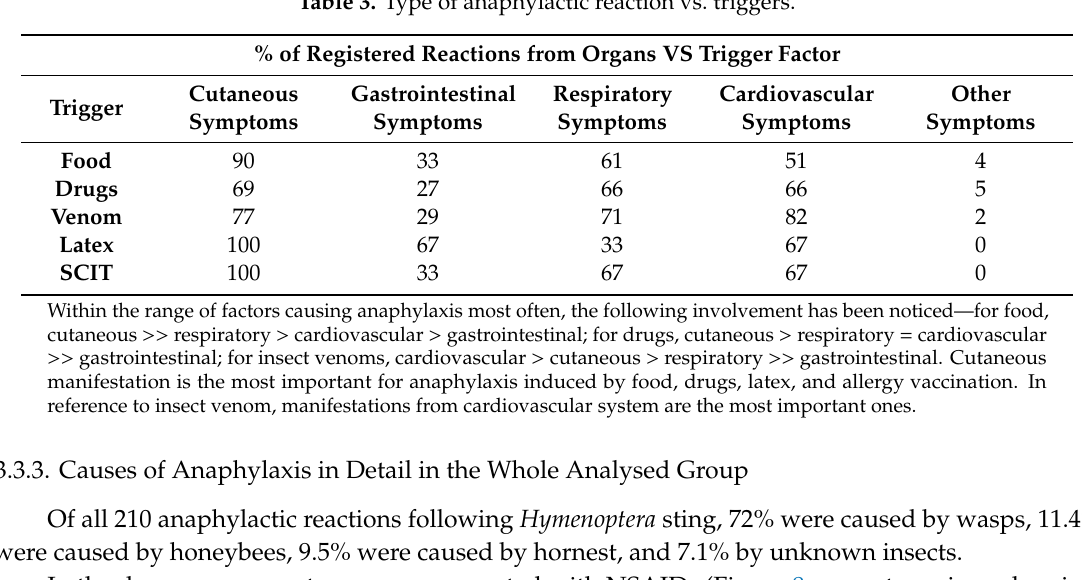
Table 3. Type of anaphylactic reaction vs.